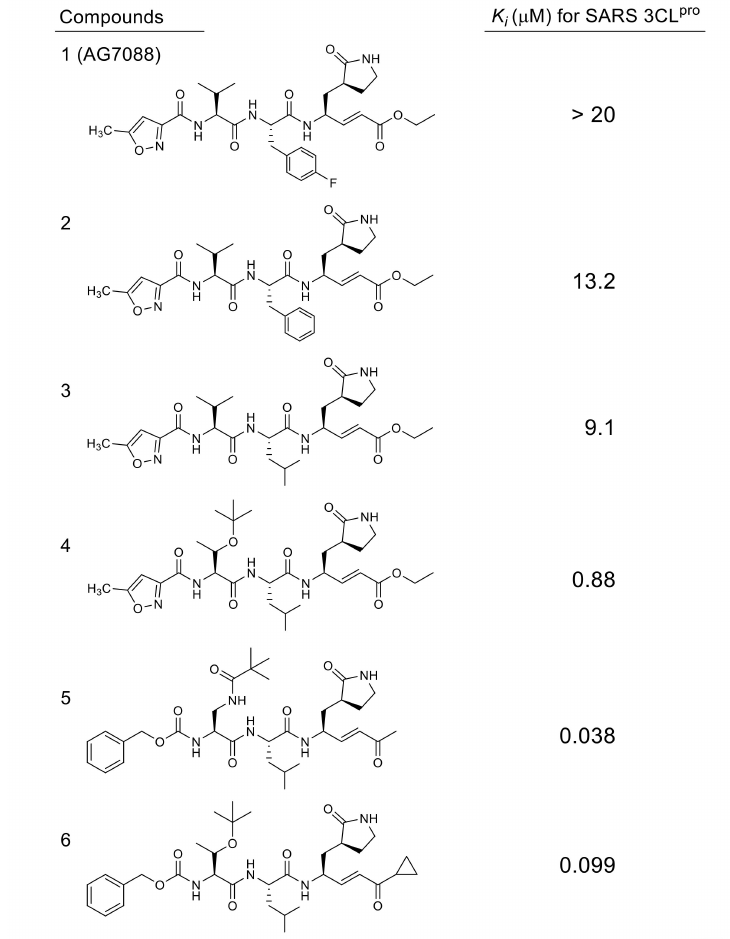
Figure 3. Inhibition of cysteine proteases by a Michael acceptor type compound. Table 1. Inhibitory activities of Michael type inhibitors against 3CL pro